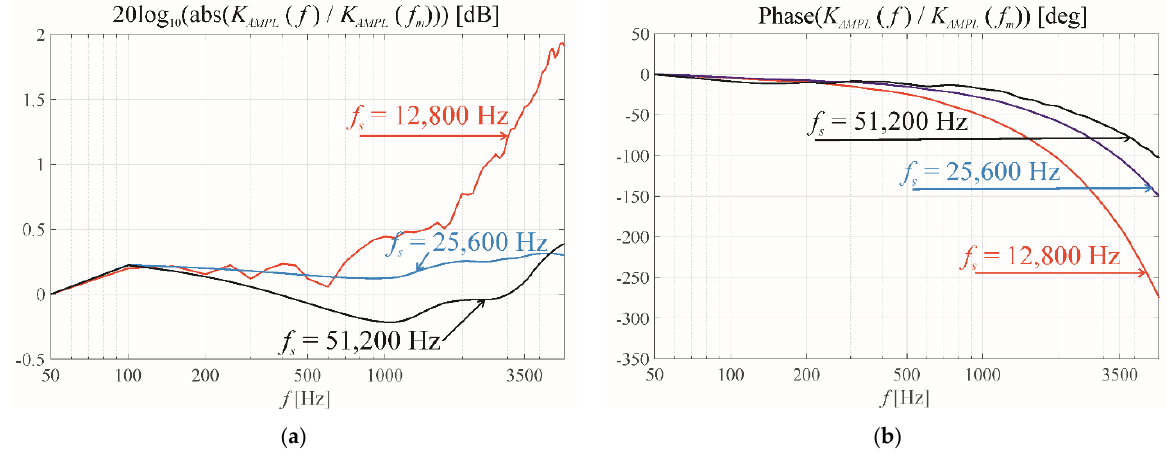
Figure 9. Bode magnitude and phase plots of the output voltage measurement trace for f s = 12,800 Hz, 25,600 Hz, and 51,200 Hz: ( a ) Magnitude; ( b ) Phase.